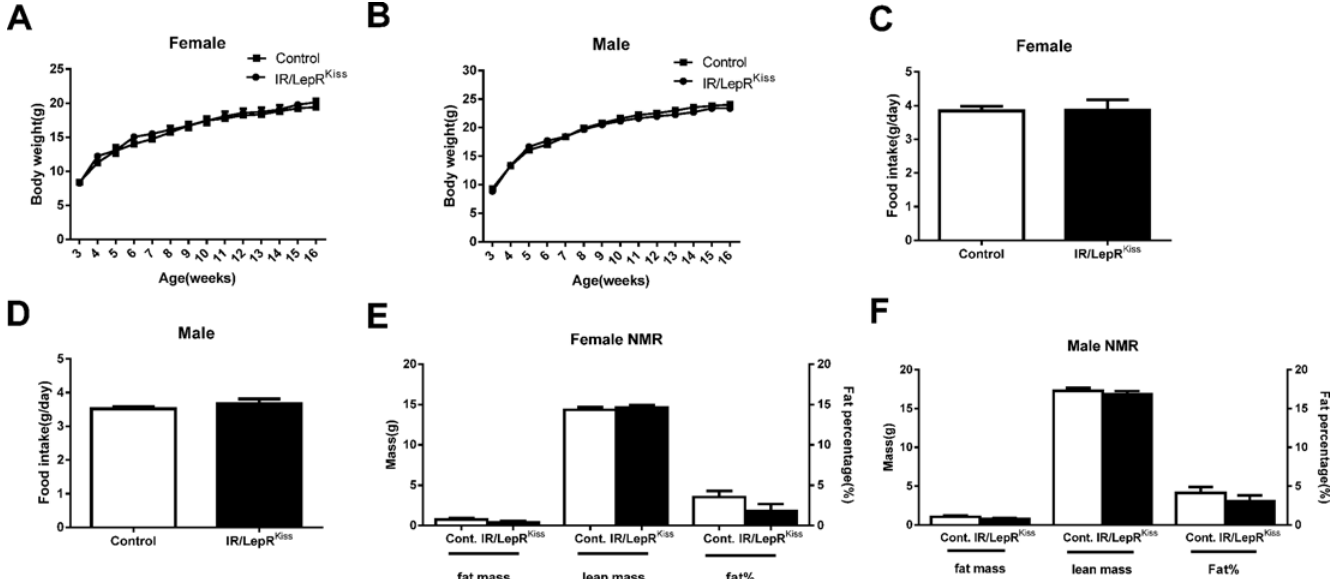
Fig 9. Metabolic phenotype in IR/LepR Kiss mice. (A) Weekly body weight of female mice (Control n = 15 and IR/LepR Kiss n = 8) mice (B) Weekly body weight of male mice (n = 16 each group). (C) Female average daily food intake calculated from weekly measurement. (D) Male average daily food intake calculated from weekly measurement. (E) Female body composition at the age of 4 months in control (n = 13) and IR/LepR Kiss (n = 7) mice. (F) Male body composition at the age of 4 months in control (n = 15) and IR/LepR Kiss (n = 12) mice.